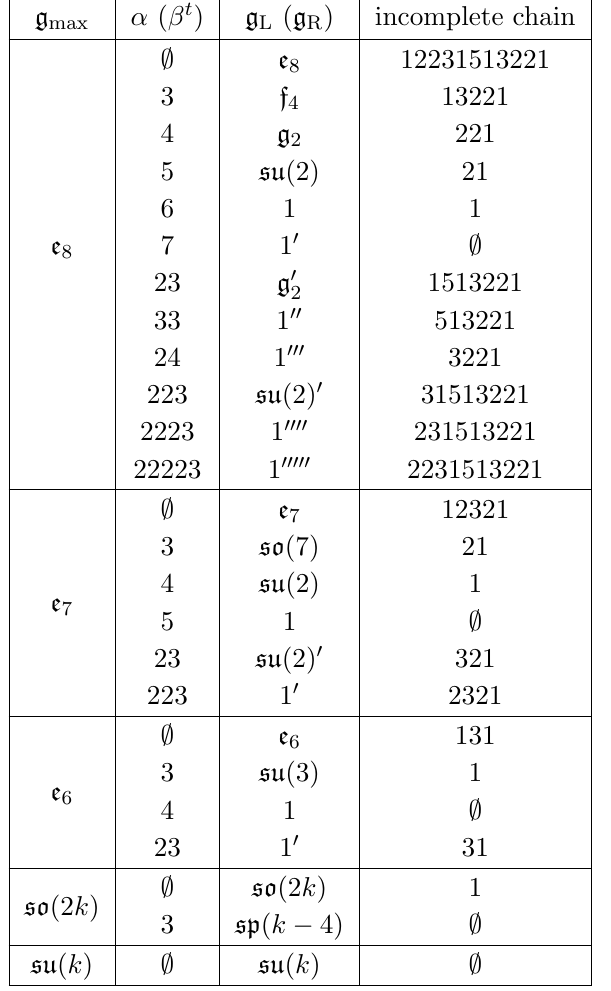
Table 1 . Choices of g L ( g R ) as a function of g max and endpoint (cid:11) ( (cid:12) t ), where the superscript t in- dicates that we reverse the order of the curves by transposition. We also tabulate the corresponding incomplete chains (or their transpose) appearing after the leftmost (rightmost) g max